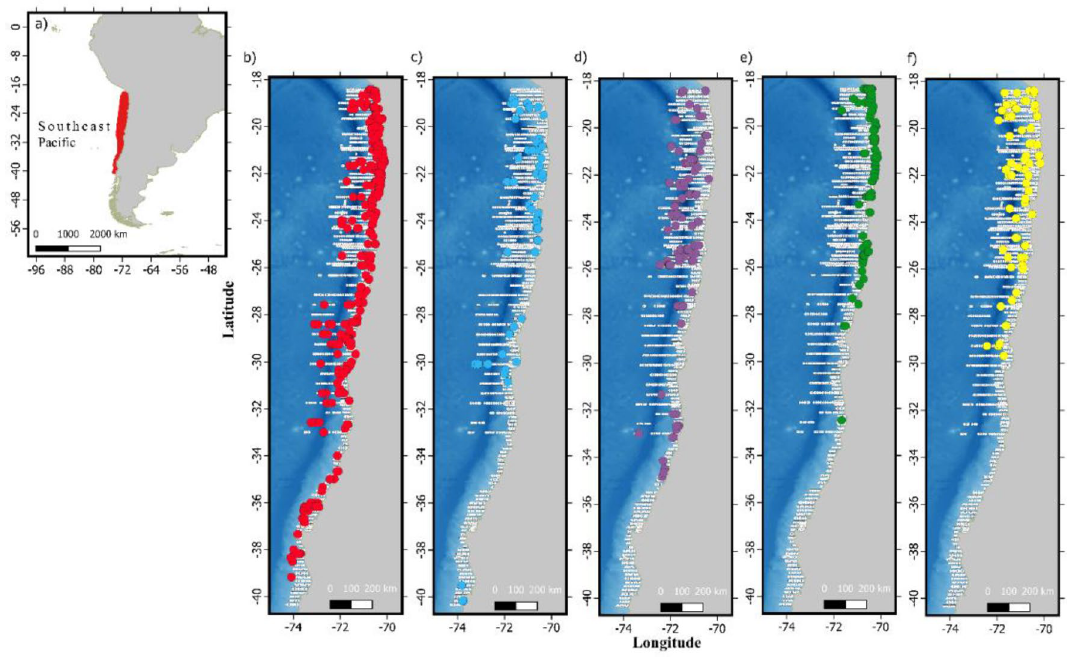
Figure 1. ( a ) Red polygon indicates the location and coverage of the study area in the Southeast Pacific. ( b ) Red points indicate fin whale sightings, ( c ) light-blue points indicate blue whale sightings, ( d ) purple points indicate sperm whale sightings, ( e ) green points indicate dusky dolphin sightings, and ( f ) yellow points indicate common dolphin sightings. Small white dots denote the midpoint for each on-effort track segment. Data layers (including maps) were created in R v. 4.0.2 (www.r- proje ct. org) and ensembled in QGIS v. 3.8.0 (www. qgis. org) for final rendering. Maps were created using data on bedrock topography from the National Centers for